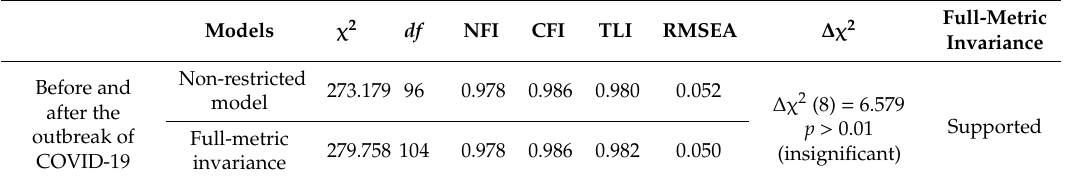
Table 4. The measurement-invariance models.